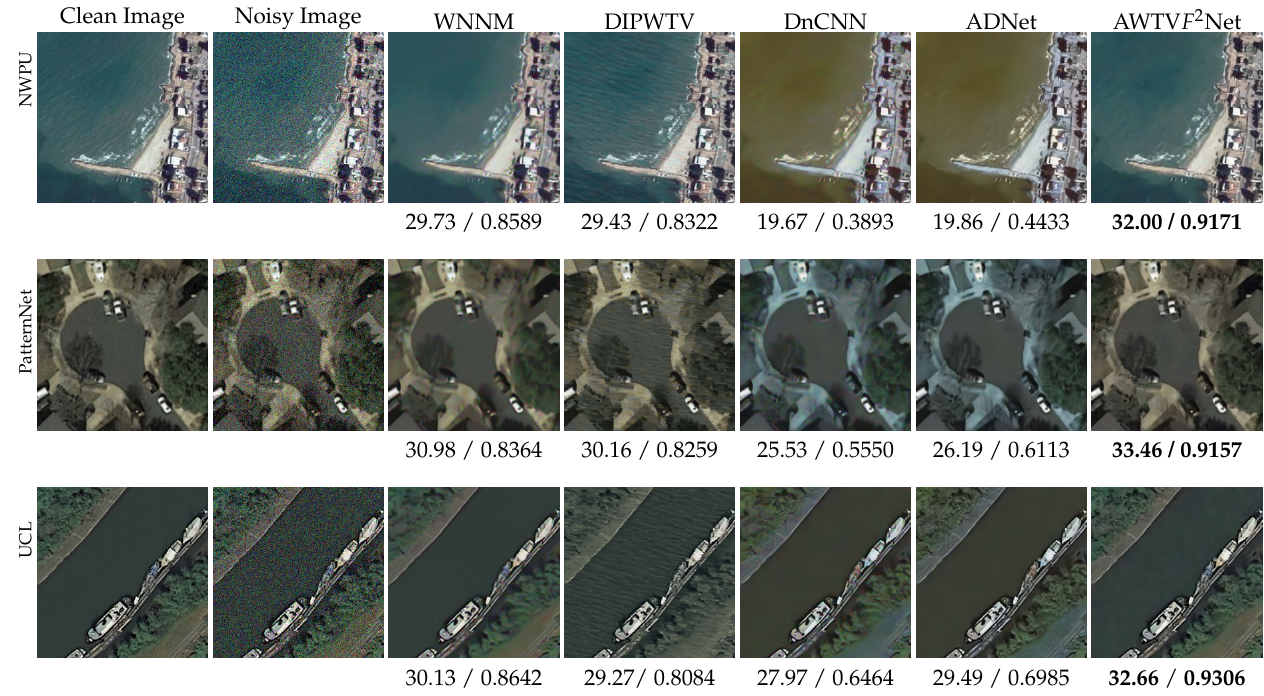
Figure 9. Denoised images in NWPU, PatternNet and UCL datasets with noise level σ 2 = 25.